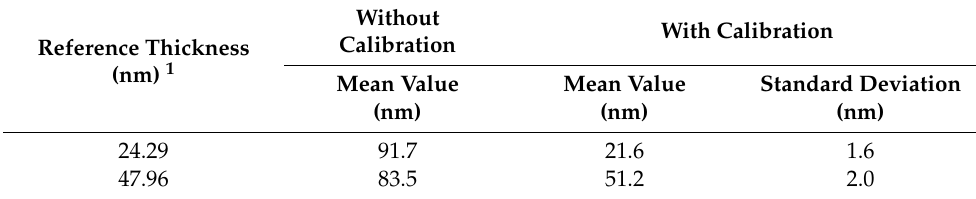
Table 5. Measurement results for thinner